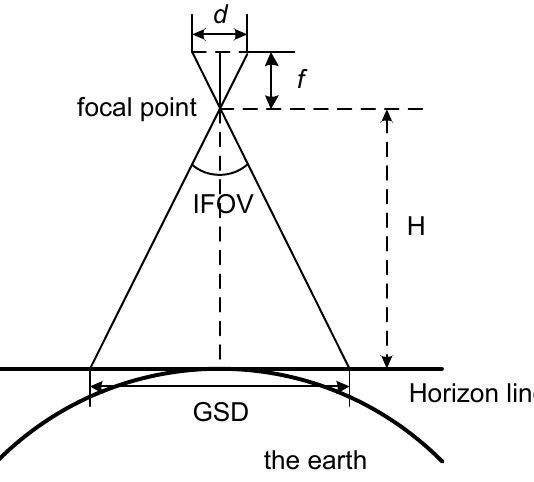
Figure 3. Geometry of the detecting